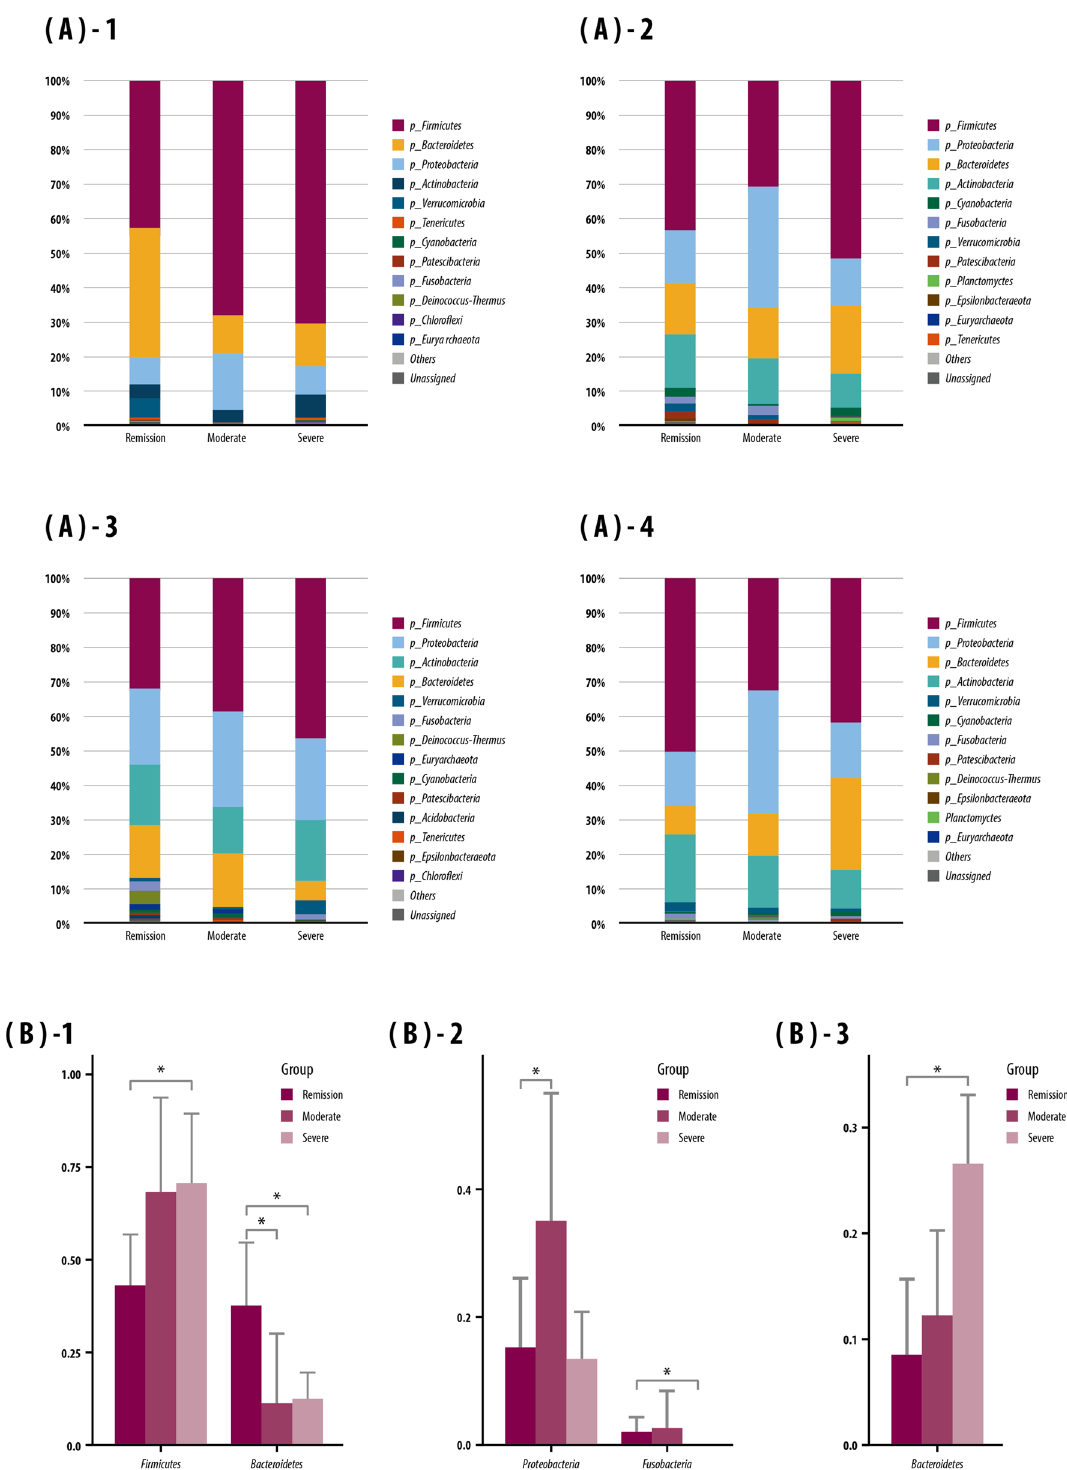
Figure 6. Microbiome composition and microbials showing significant between-group differences in abundance based on baseline disease activity [remission, mild-moderate (labeled as ‘moderate’), or severe] at the phylum level. ( A ) Composition of the microbiome in: ( A-1 ) stool; ( A-2 ) saliva; ( A-3 ) serum; and ( A-4 ) urine. ( B ) Microbials showing significant between-group differences in mean relative abundance in: ( B-1 ) stool; ( B-2 ) saliva; and ( B-3 ) urine. Kruskal–Wallis and Wilcoxon tests were used. Bars above columns indicate standard deviation. * p <